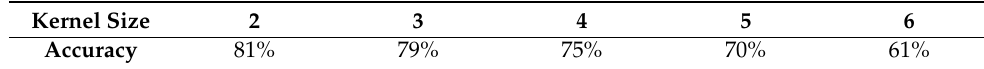
Table 6. The accuracy obtained for different convolution kernel sizes. Kernel Size